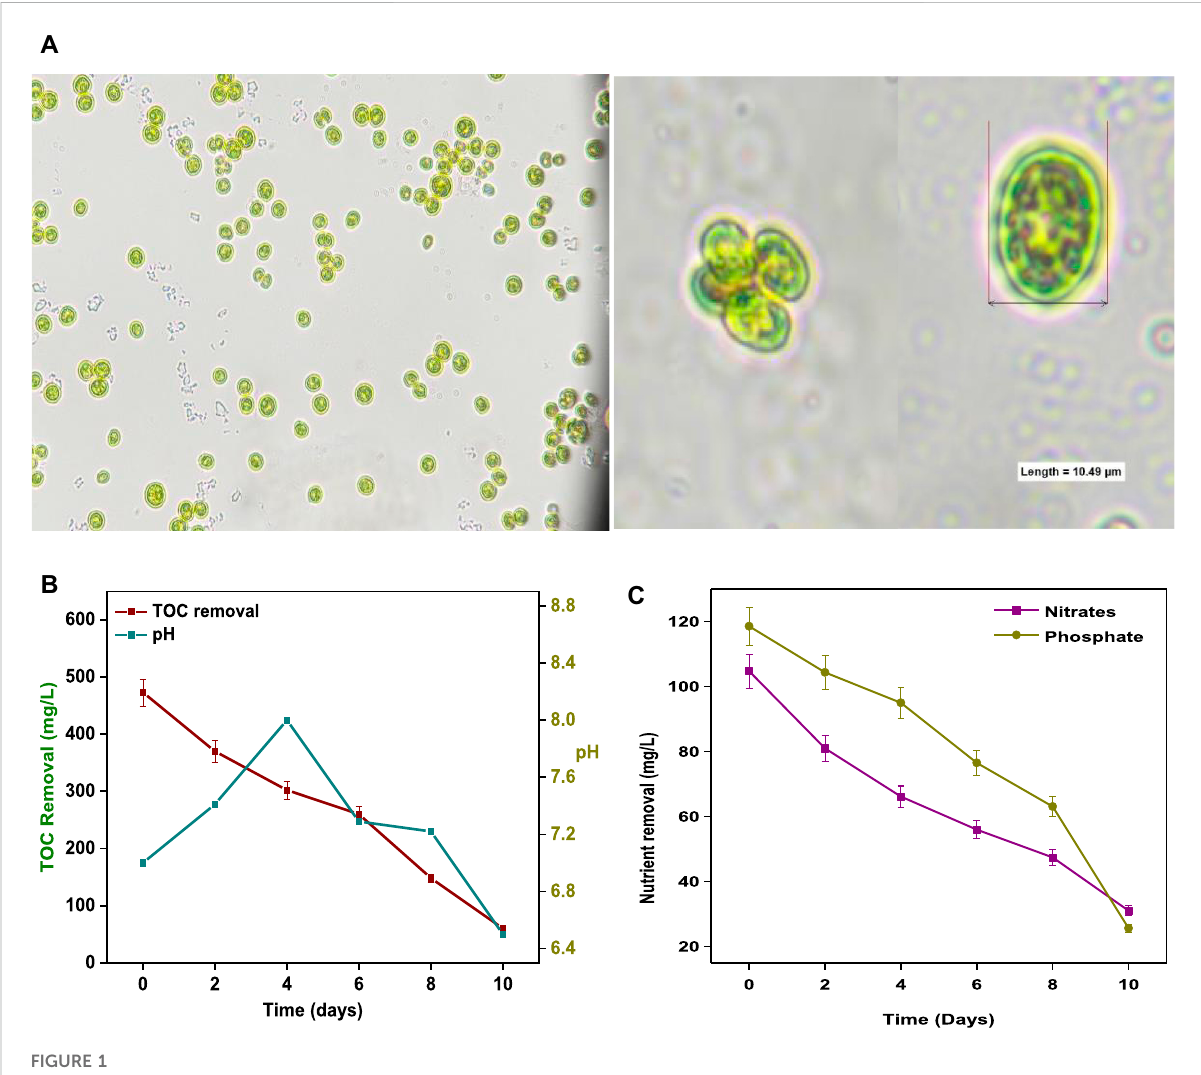
FIGURE 1 (A) Microscopicimages and (B) sizeandshape of Coelestrella sp. (B) TOCremovalandpHchange and (C) nutrientremoval withrespecttotime during SDWW